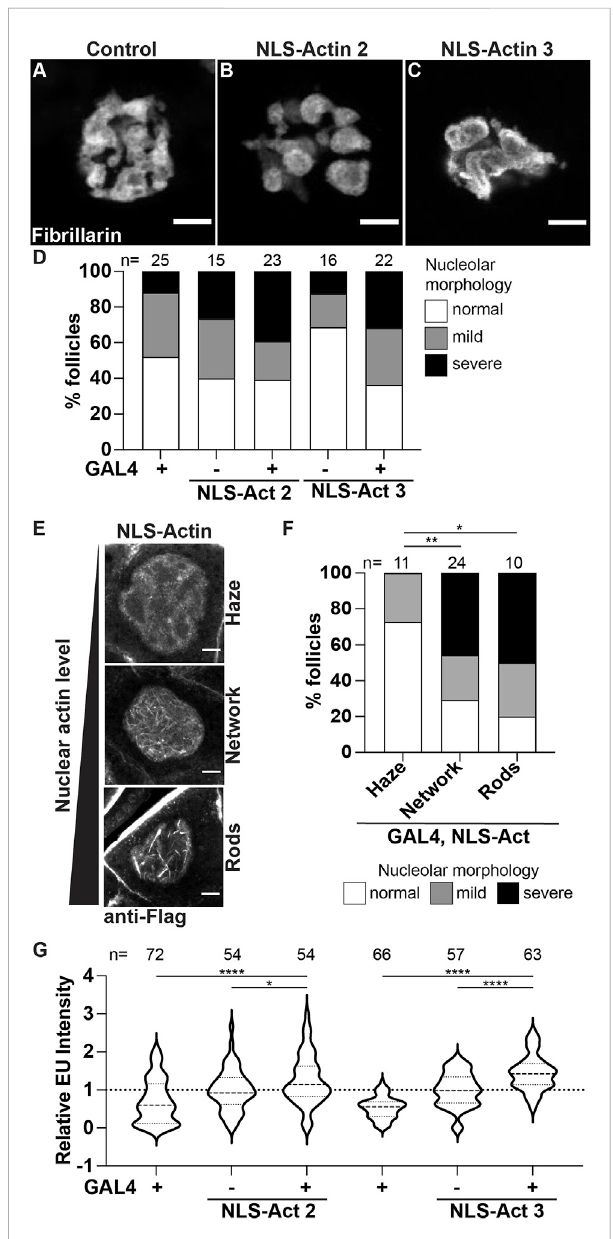
FIGURE 6 Increasing nuclear actin levels alters nucleolar morphology and increases nucleolar activity. (A – C) . Maximum projections of 2- 4 confocal slices of Control ( osk GAL4/+ )and NLS-Actin ( osk GAL4/+; UASNLS- fl ag-Actin 5C/+ )overexpressingsingleS10B nursecells stained for the nucleolus (Fibrillarin). (D) . Graph quantifying the percentage of follicles exhibiting normal (white) vs. mild (gray) or severe (black) defects in nucleolar morphology. (E) .